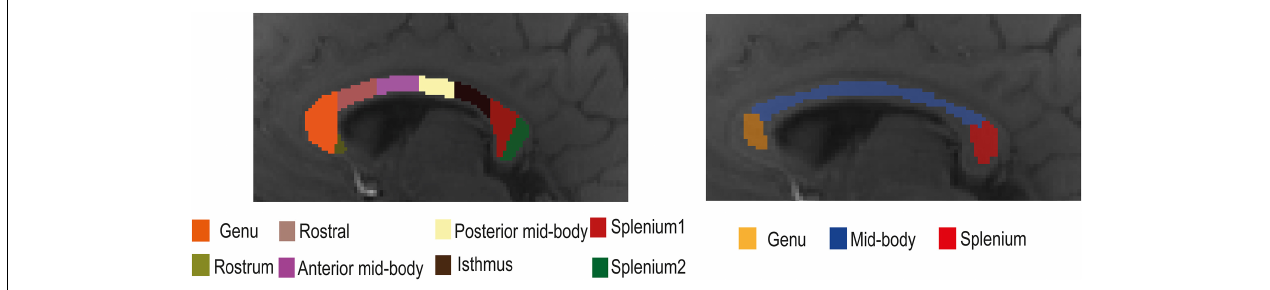
FIGURE 1 | Illustration of the location of the eight (left) and three (right) regions of interest (ROIs) in the mid-sagittal plane of the corpus callosum used in the gradient-recalled echo (GRE)-MRI signal compartment model analysis. TABLE 1 | Summary of models investigated and parameter settings used for each model indicating where values were either fixed or free (i.e., X). Model